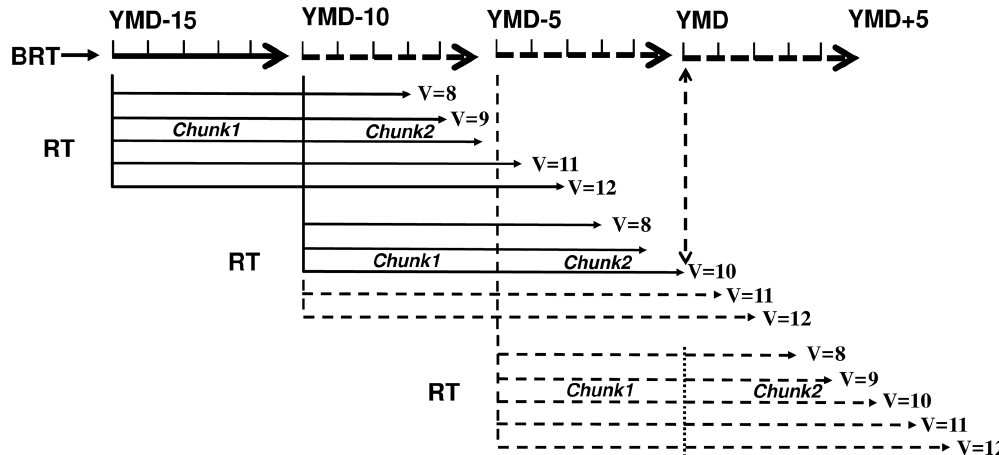
Figure 15. Schematic plot of OCEAN5 BRT and RT components: YMD: current model date; V : variable assimilation window length in the RT component. Solid lines denote analyses already produced in either the BRT or RT component; dashed lines denote analyses not yet